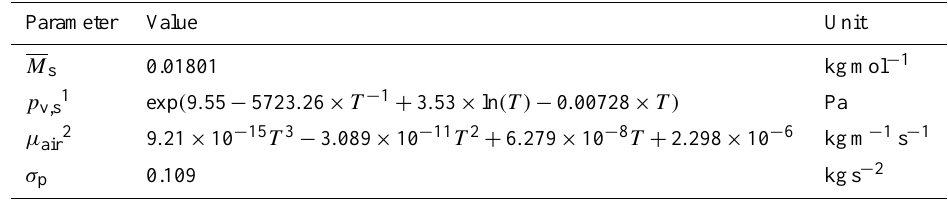
Table 1. Thermal and transport properties of air and